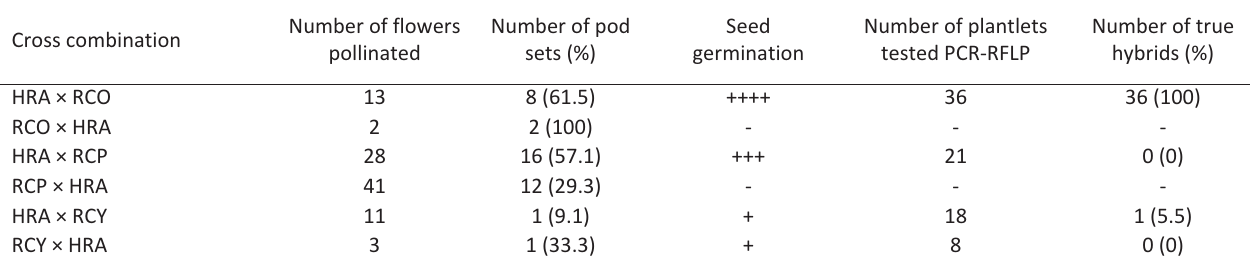
HRA = H. radiate ; RCO = H. rhodocheila (orange petal); RCP = H. rhodocheila (pink petal); RCY = H. rhodocheila (yellow petal). *++++ = Germination well, ++ = Germination fair, + = Germination poor, ­ = No